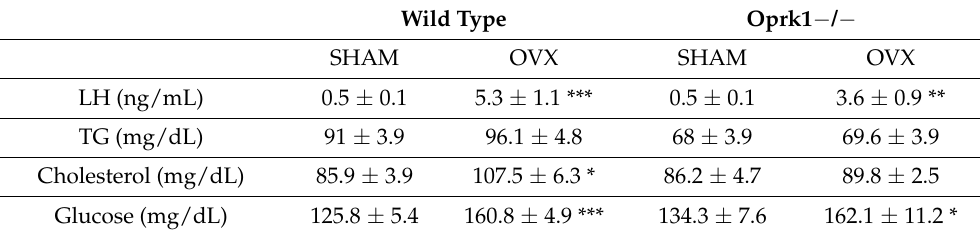
Table 1. Serum physiological parameters in SHAM and OVX, and female mice at 11 weeks after surgery. Values are expressed as mean ± SEM. t -test or Mann–Whitney test were performed to evalu- ate differences between groups indicating significant differences compared to SHAM (*). p < 0.05 (*), p < 0.01 (**), p < 0.001 (***). LH, luteinizing hormone; TG,